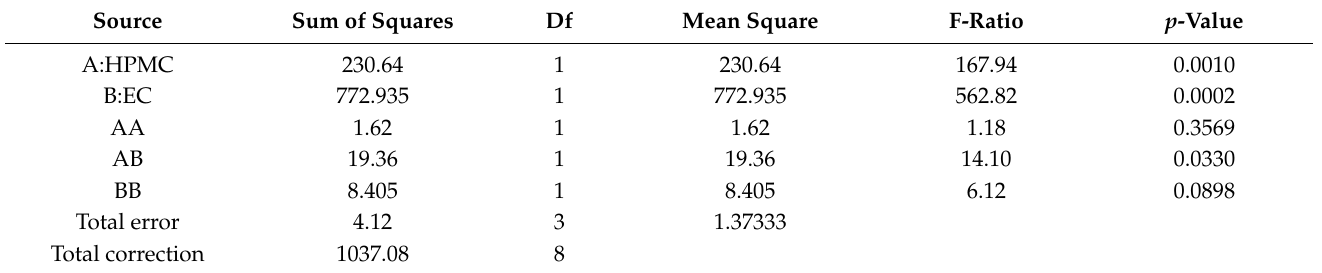
Figure 8. ( A – C ) The response surface plot ( A ), contour plots ( B ), and main effects plots ( C ) estimate the effect of independent variables on % released after 12 h. Table 8. Analysis of variance for the % released after 12 h.